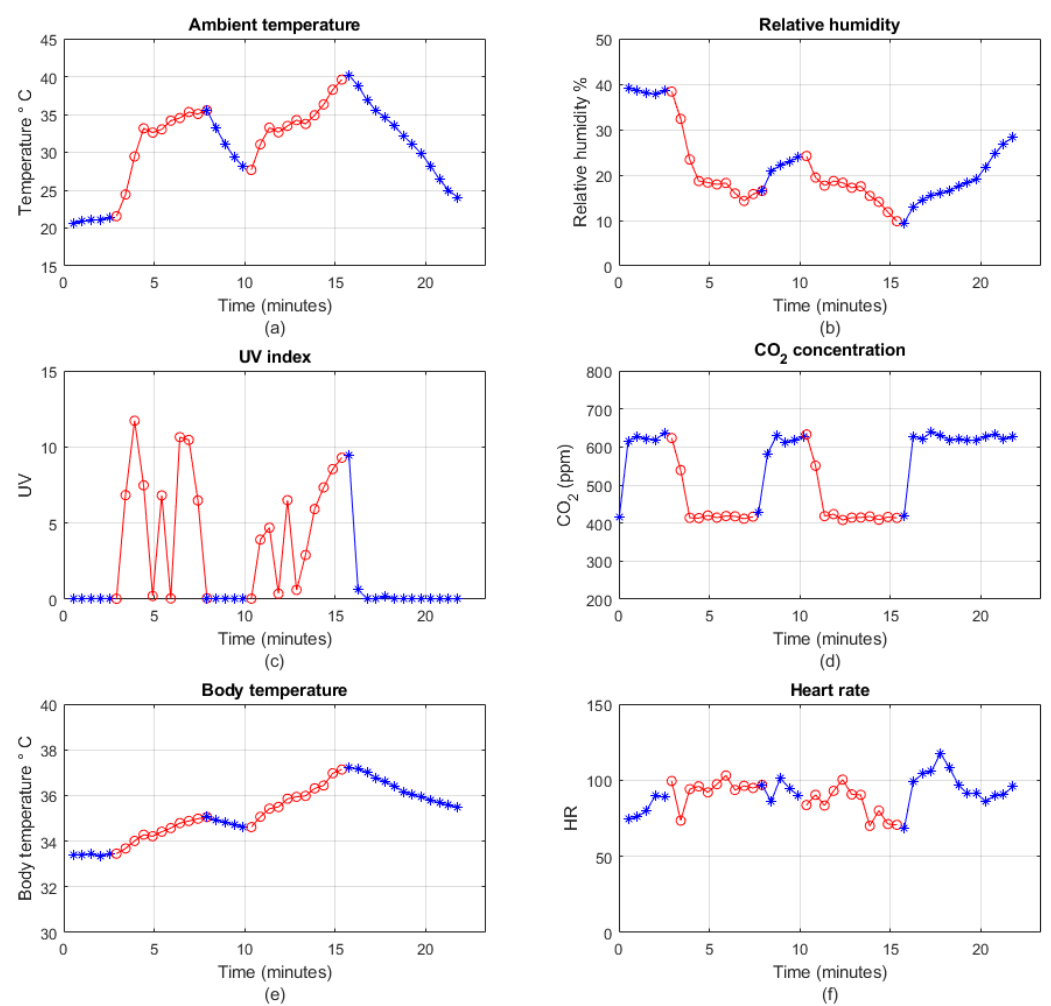
Figure 9. Real-time monitoring of different sensors’ data: ( a ) temperature; ( b ) relative humidity; ( c ) UV index; ( d ) carbon dioxide; ( e ) body temperature; ( f ) heart